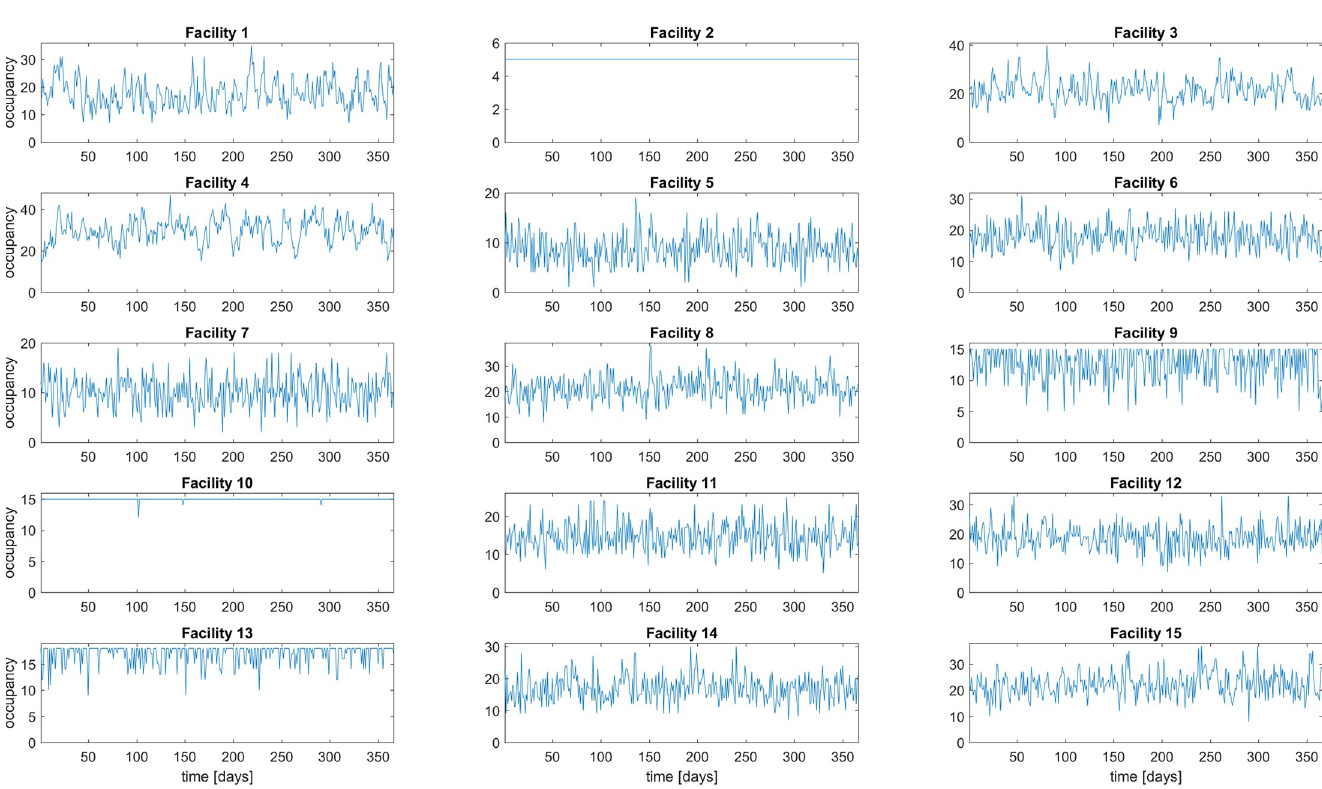
Fig 3. Example MTF occupancy time series, for the 90 casualties / source / day case. The horizontal axis is days and the vertical axis is MTF occupancy. The vertical axis limit of each plot is one patient more than the capacity of that MTF, therefore the fullness at each time step is approximately the ratio of the plotted occupancy to the vertical limit of the plot. E.g., MTFs 2 and 10 have fullness values equal to or close to 1 for most of the simulated period, MTFs 9 and 13 often reach a fullness of 1, and the remaining MTFs have fullness values that varying around roughly